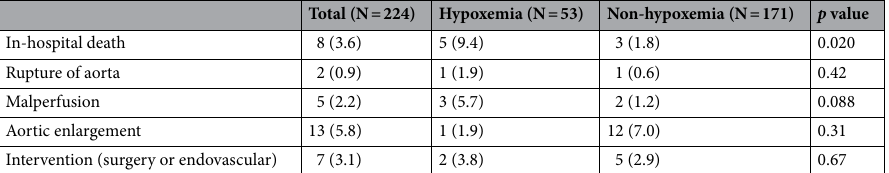
Table 4. Clinical events in patients with type-B acute aortic syndrome. Values are median (interquartile range), or n